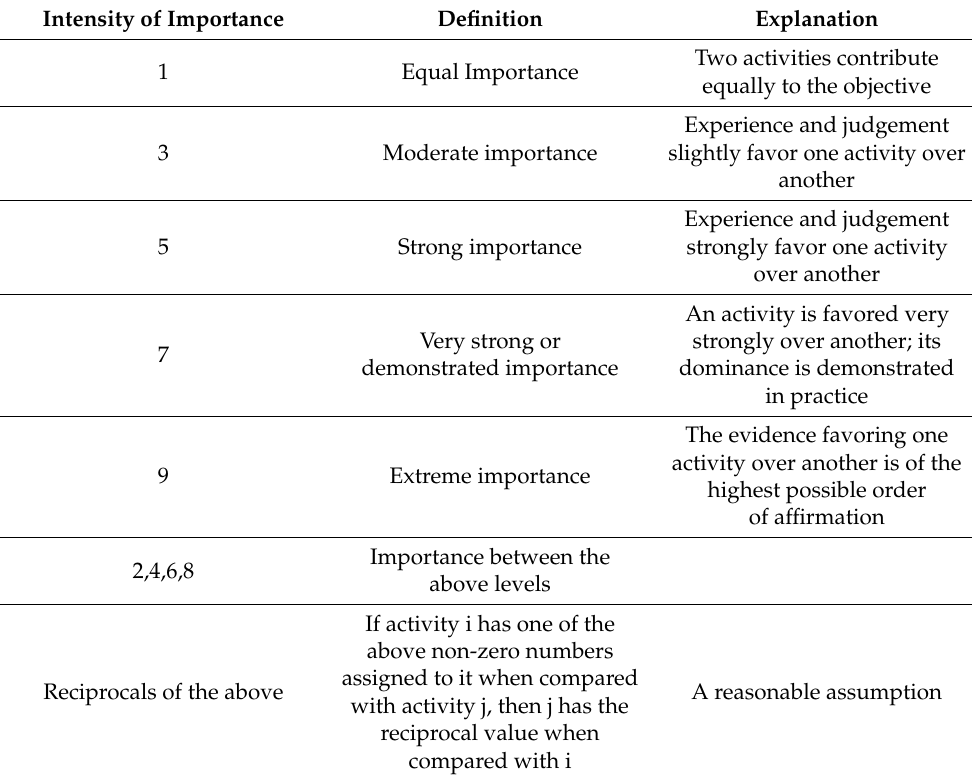
Figure 1. Hierarchical analysis structure graph. Table 2. The fundamental scale of absolute